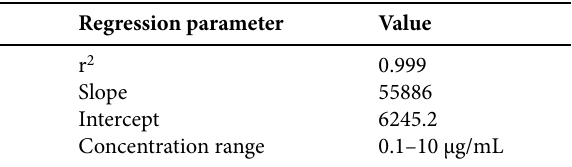
Table 1. Linearity data of analytical assay Regression parameter